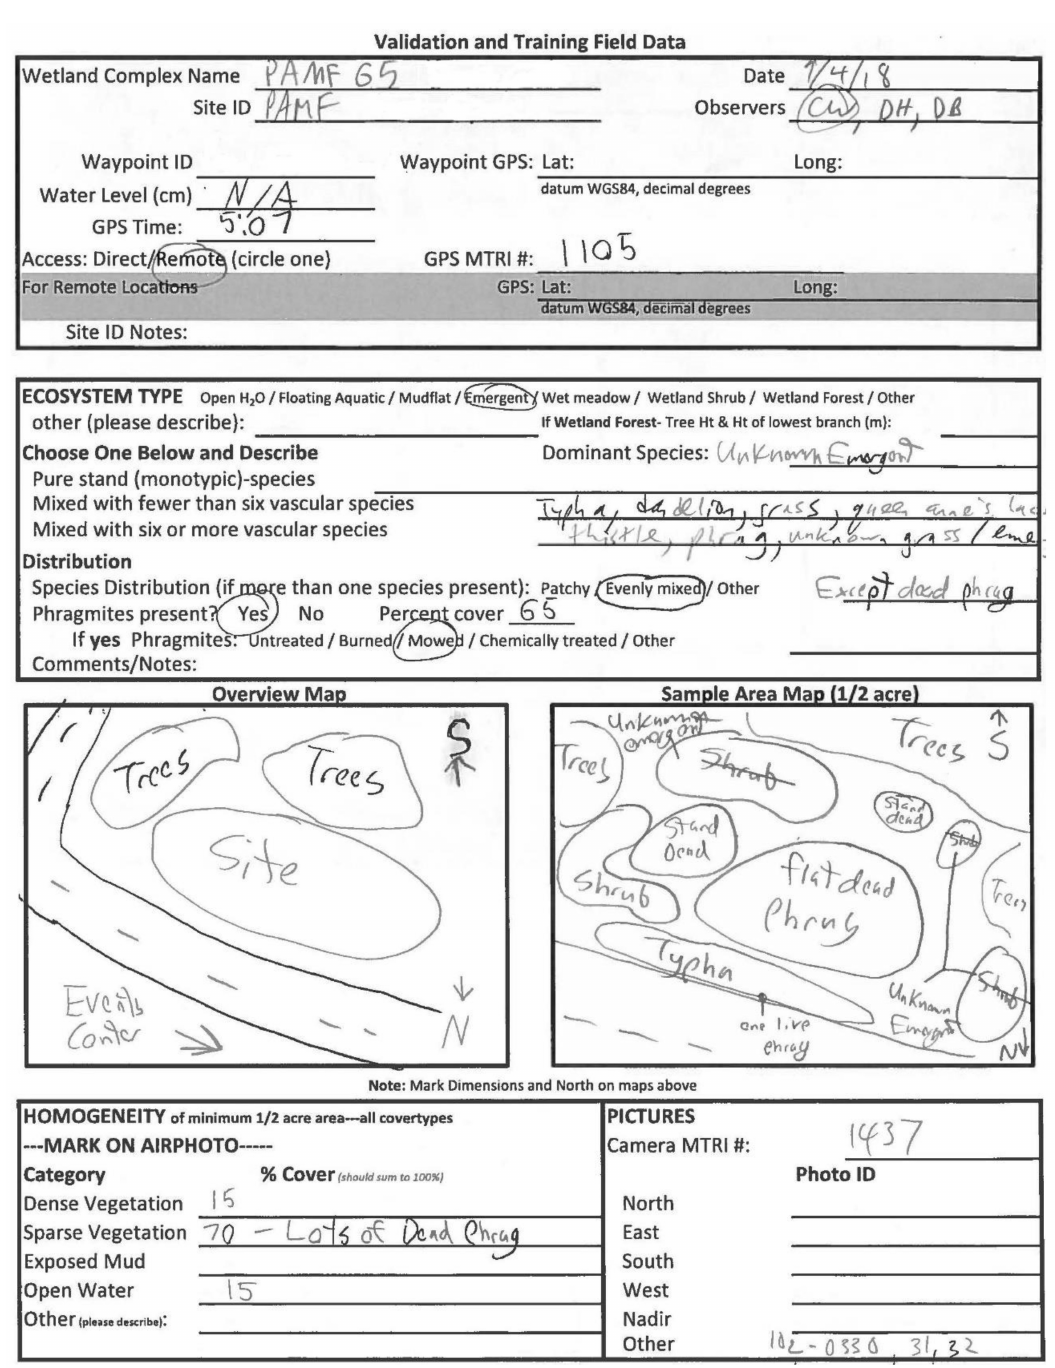
Figure 5. Example field sheet used to help record site